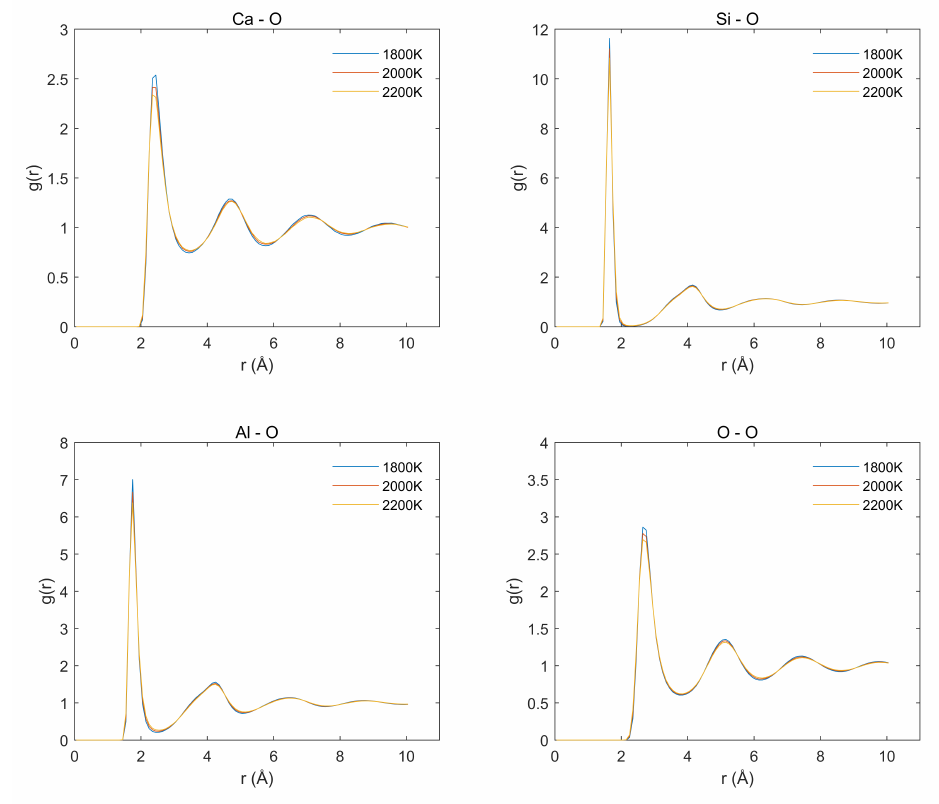
Figure 5. Radial pair distribution functions g ( r ) of various pairs of atoms for CaO–Al 2 O 3 –SiO 2 systems with 15 wt% CaO at different